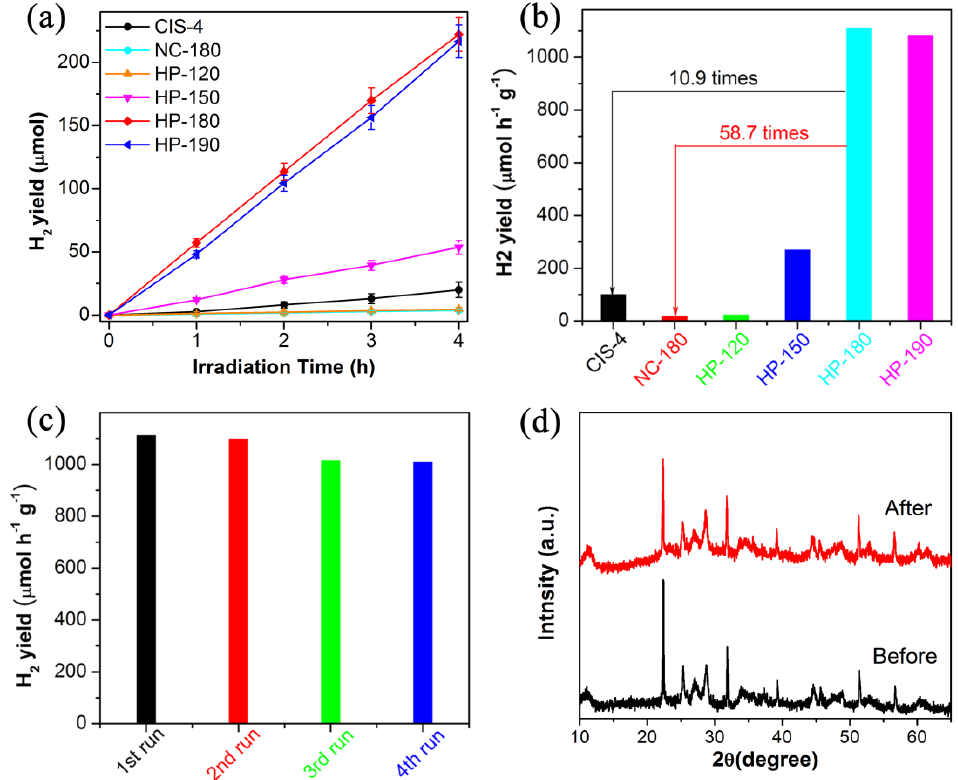
Figure 6. Comparison of photocatalytic activity ( a ) H 2 production versus time and ( b ) H 2 evolution rate over pristine CIS ‐ 4, NC ‐ 180, HP ‐ 120, HP ‐ 150, HP ‐ 180 and HP ‐ 190; ( c ) recyclability experiment of photocatalytic H 2 generation over HP ‐ 180; ( d ) XRD patterns of HP ‐ 180 before and after test.